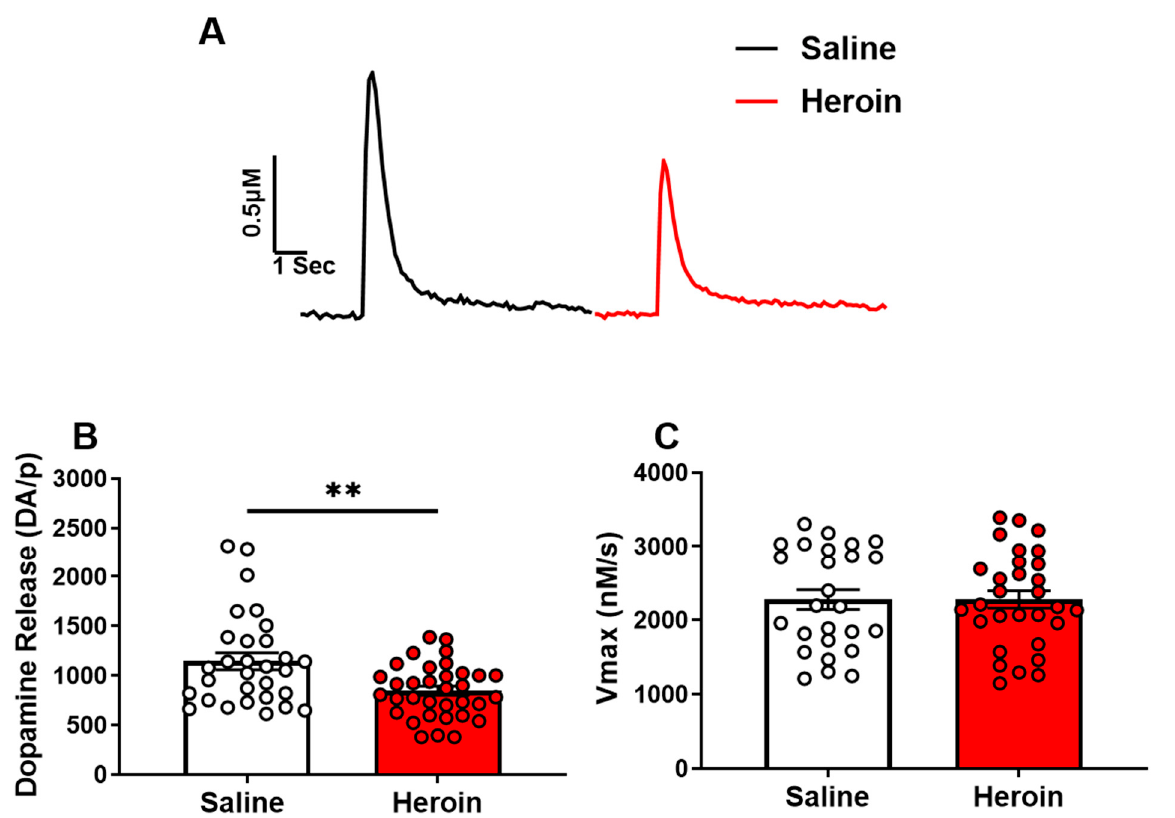
Figure 2. Heroin self-administration reduced single-pulse stimulated dopamine release, but not dopamine reuptake in the NAc core. ( A ) Representative traces of electrically-evoked dopamine in saline exposed (black) and heroin exposed (red) rats. ( B ) Stimulated dopamine release was significantly lower in heroin-exposed rats. ( C ) The maximal rate of dopamine uptake (Vmax) was not significantly different between saline and heroin-exposed rats. ** p < 0.01.